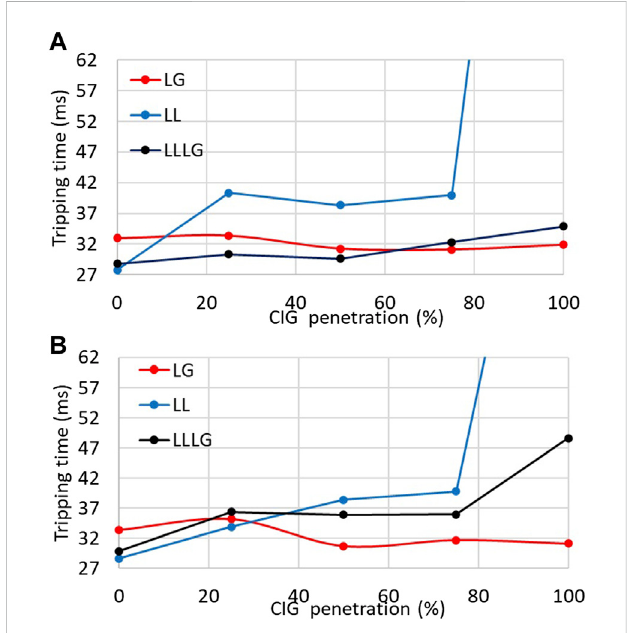
FIGURE 7 Protection tripping times using limited grid-feeding converter with